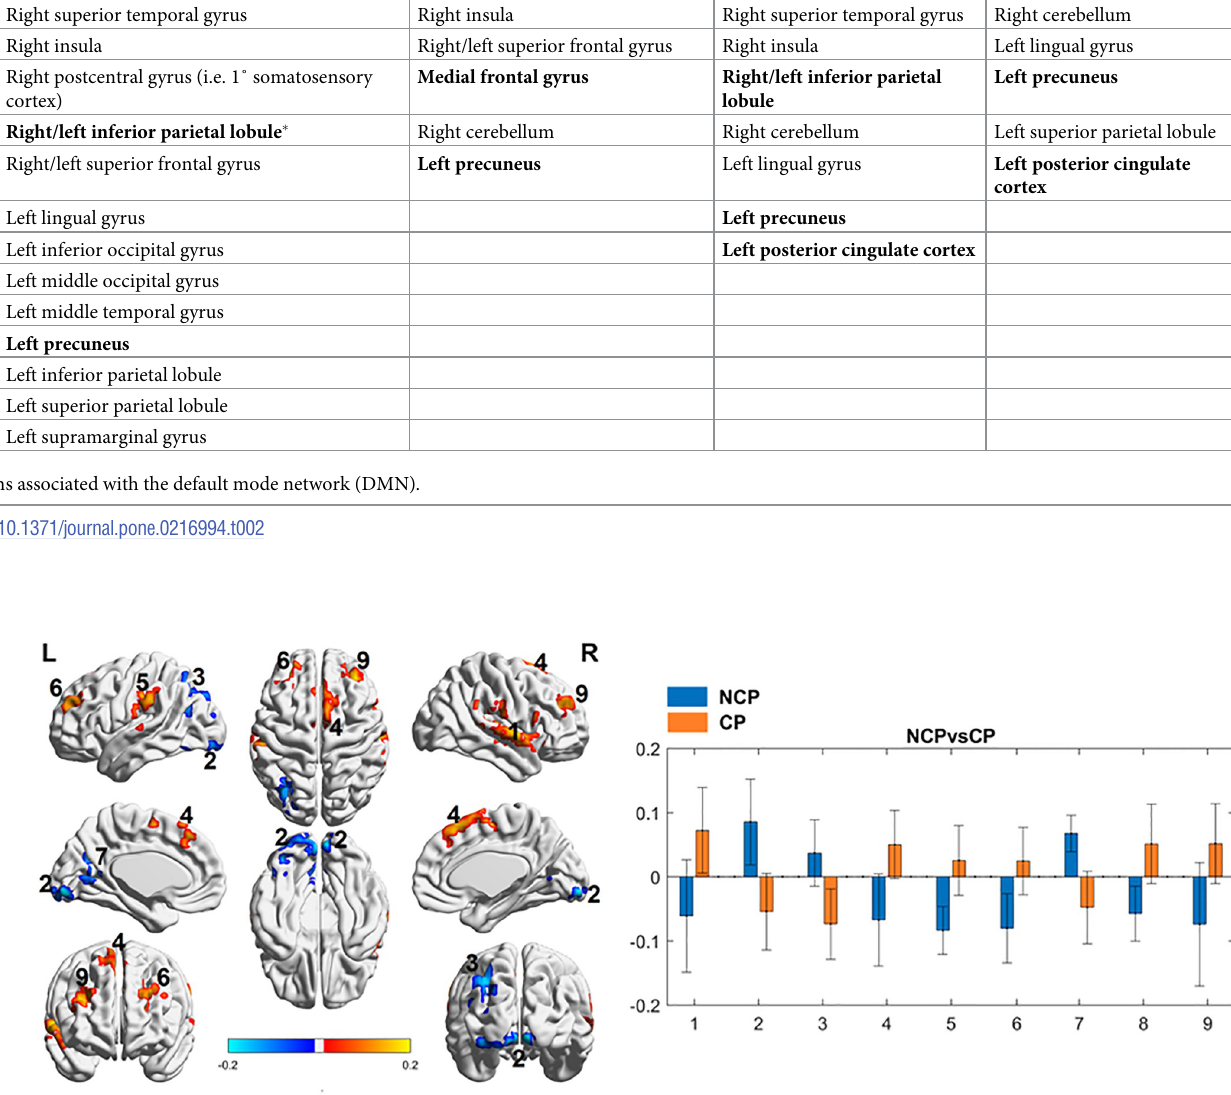
PLOS ONE | https://doi.org/10.1371/journal.pone.0216994 May 20,